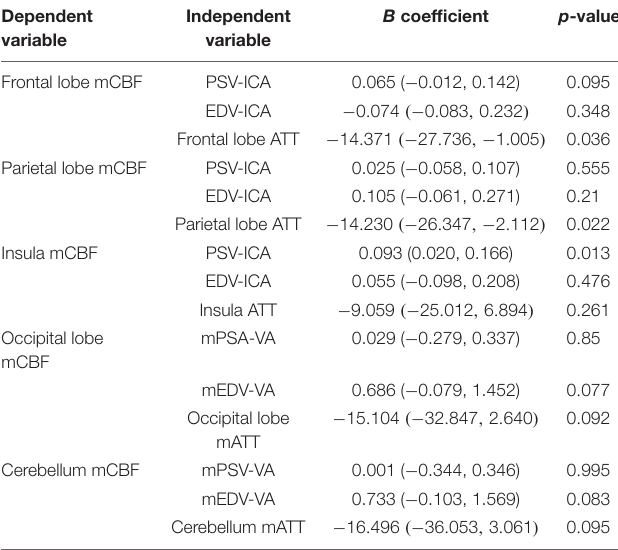
TABLE 3 | Results from multiple linear regression of the extracranial artery flow velocity, ATT on CBF in the anterior and posterior circulations of the control group.